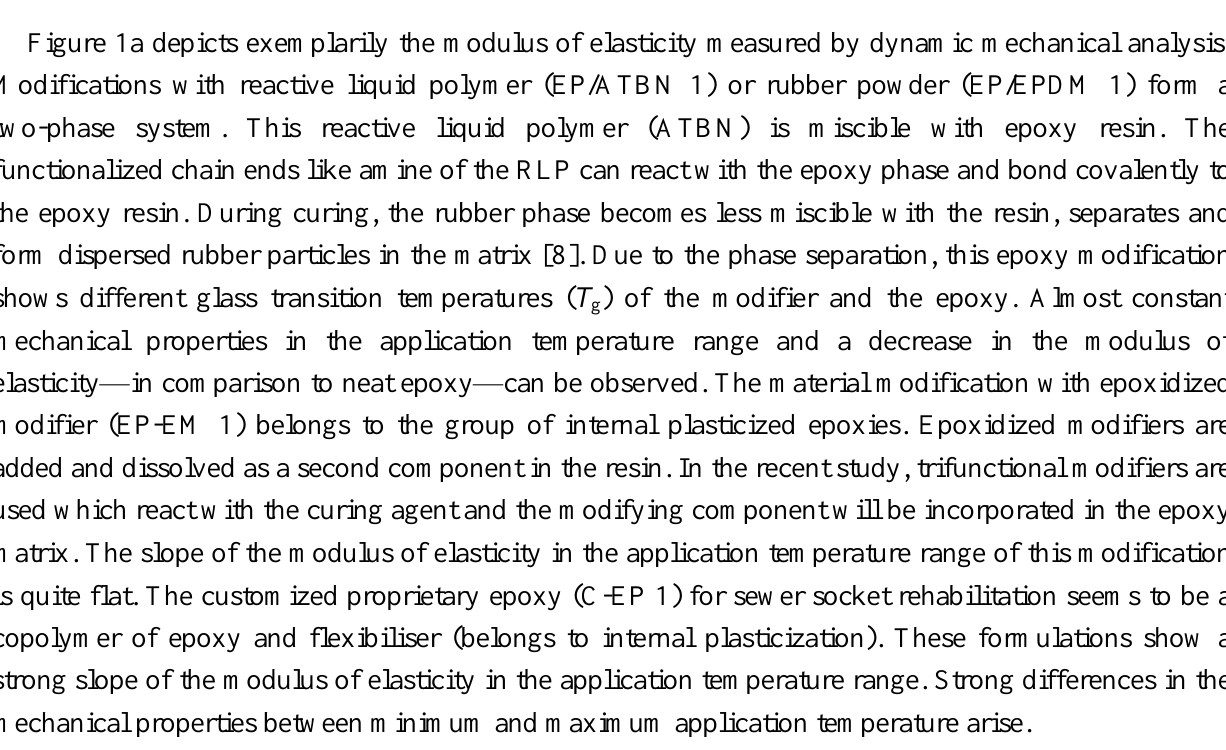
Figure 1. Results determined by dynamic mechanical analysis. ( a ) Storage modulus (Eʹ), examples of characteristic curves; ( b ) Change of glass transition temperature T water exposure for 28 days at 40